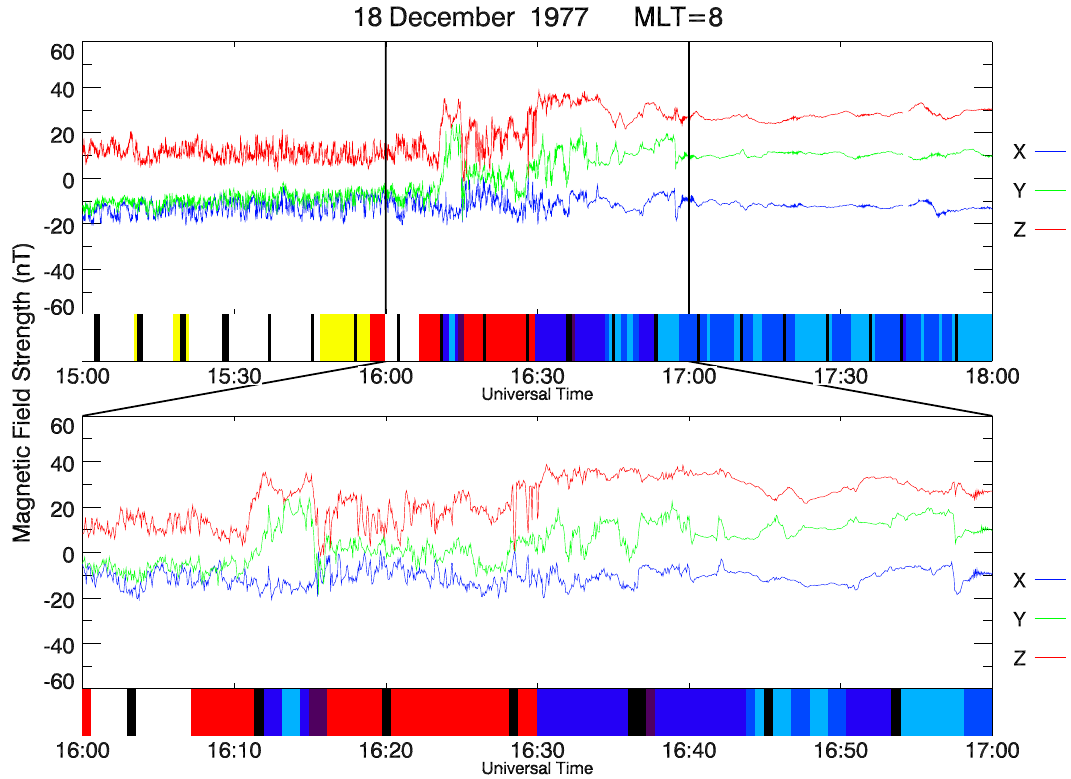
Fig. 12. A plot in the format of Fig. 4 for 18 December 1977 (Day352) from 15:00UT to